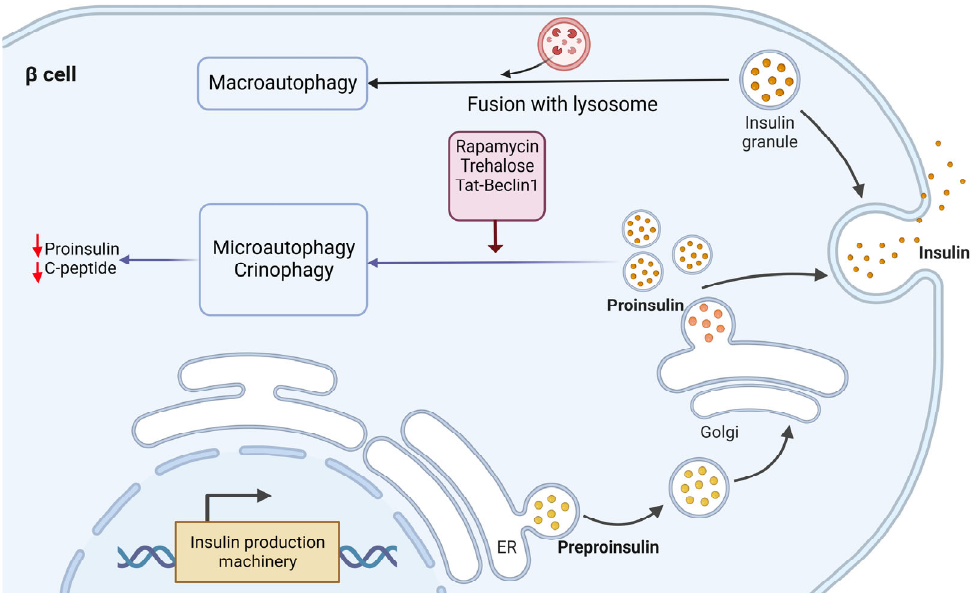
Figure 3. Molecular mechanism of proinsulin and insulin relation with autophagy in ER-Golgi pathway. The degradation mechanism of insulin and proinsulin by lysosomes seem to be different. Proinsulin is mainly degraded via macroautophagy, while insulin granule degradation is through microautophagy and crinophagy. Induction of autophagy by pharmacological stimulators (rapamycin and trehalose) and genetic interference using Tat-beclin-1 exhibited reduced proinsulin content in β cells without a ff ecting the insulin amount.